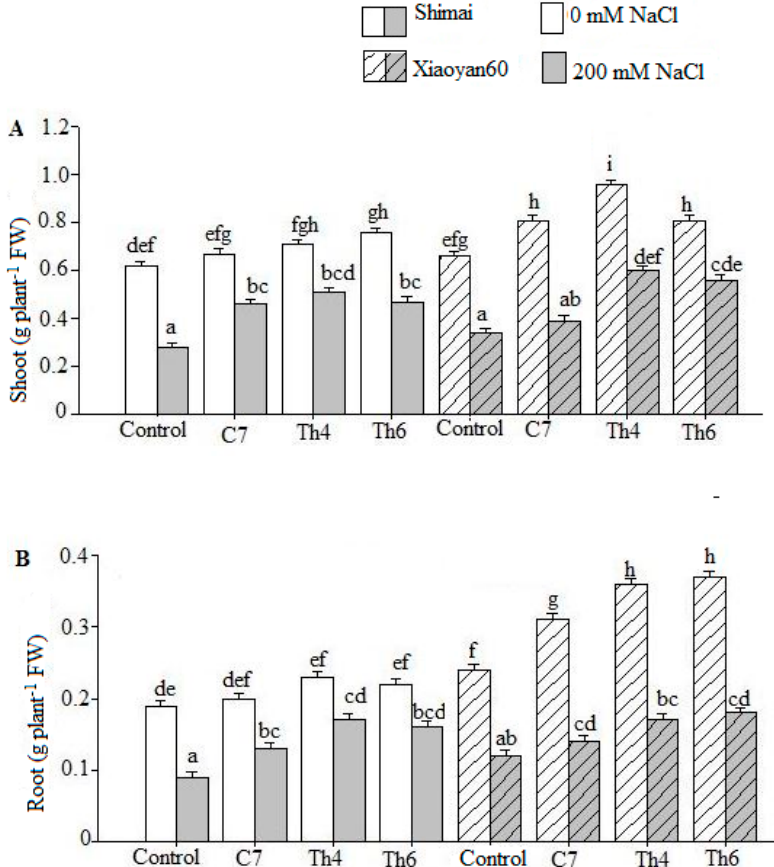
Figure 3. Biomass production of Shimai and Xiaoyan60 under microbe and salt stress treatments. Control, C7, Th4, and Th6 represent uncoated seeds, C7 seed coating, Th4 seed coating, and Th6 seed coating, respectively. The plant was harvested from the hydroponic vessel at the end of the experiment (32 days after sowing). The shoot ( A ) and root ( B ) fresh samples were wiped dry using soft paper towel, and the fresh weight was recorded immediately. The values are the means of three replicates ± SE, ( n = 3). The wheat cultivars: Shimai in white-gray bars and Xiaoyan60 in white-gray bars with course pattern. Different letters denote significant differences between the treatments and the cultivars according to Tukey-adjusted comparisons ( p < 0.05). Means sharing a letter are not significantly different. Table 4. Plant biomass production for the two wheat cultivars (C) in response to microbial treatment (M) and salt stress (S).